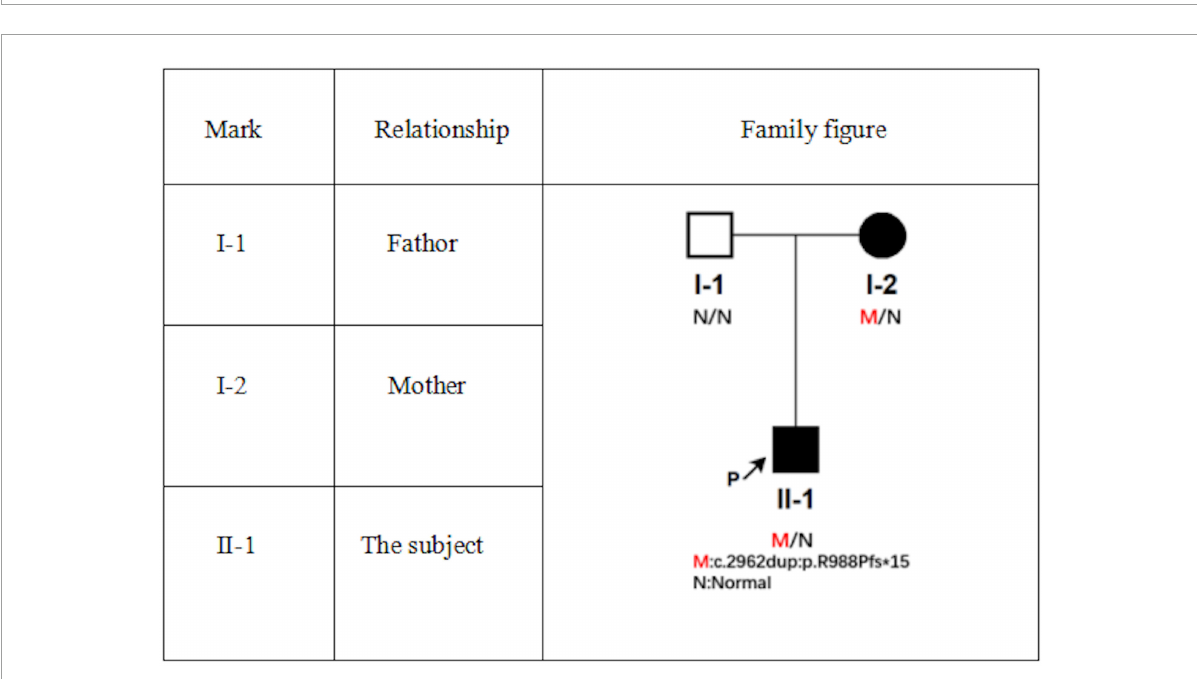
FIGURE6 Family diagram of